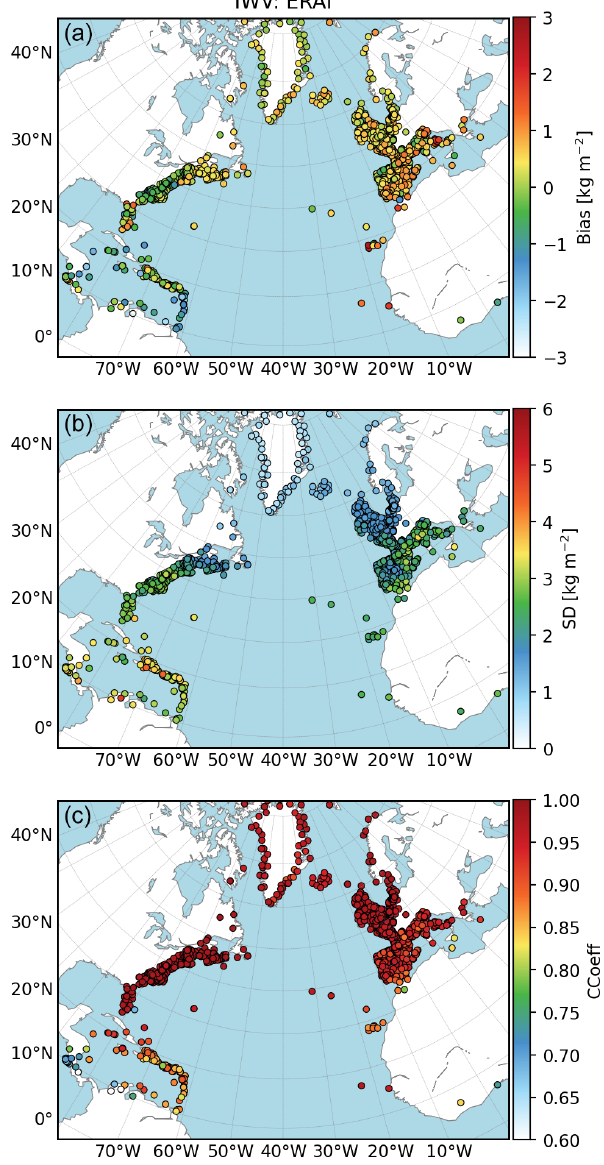
Figure 5. Same as Fig. 4 for comparisons between ERA5 and GNSS